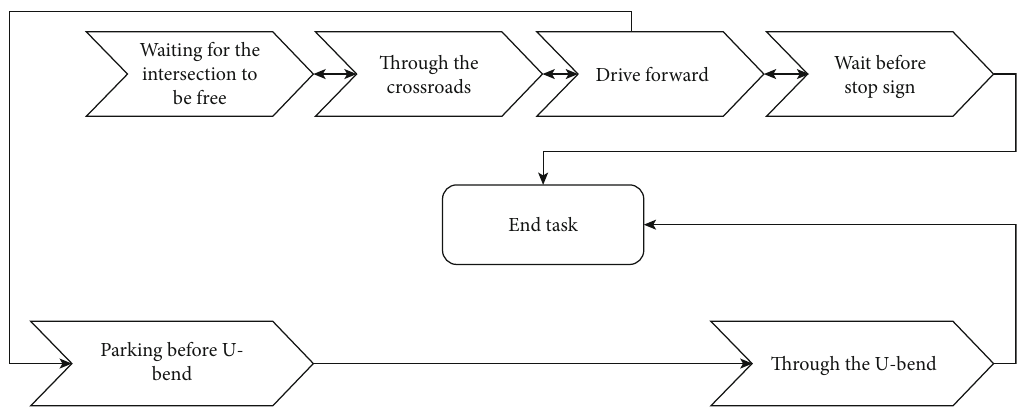
Figure 3: Unmanned driving behavior planning